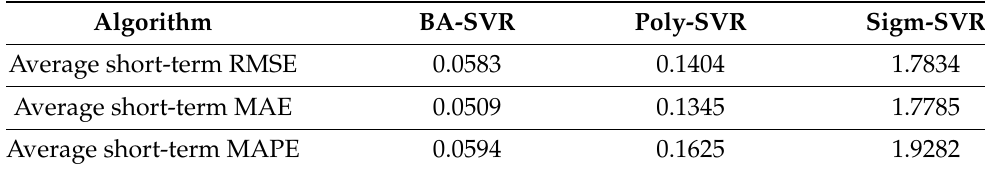
Table 7. Comparison of short-term forecast